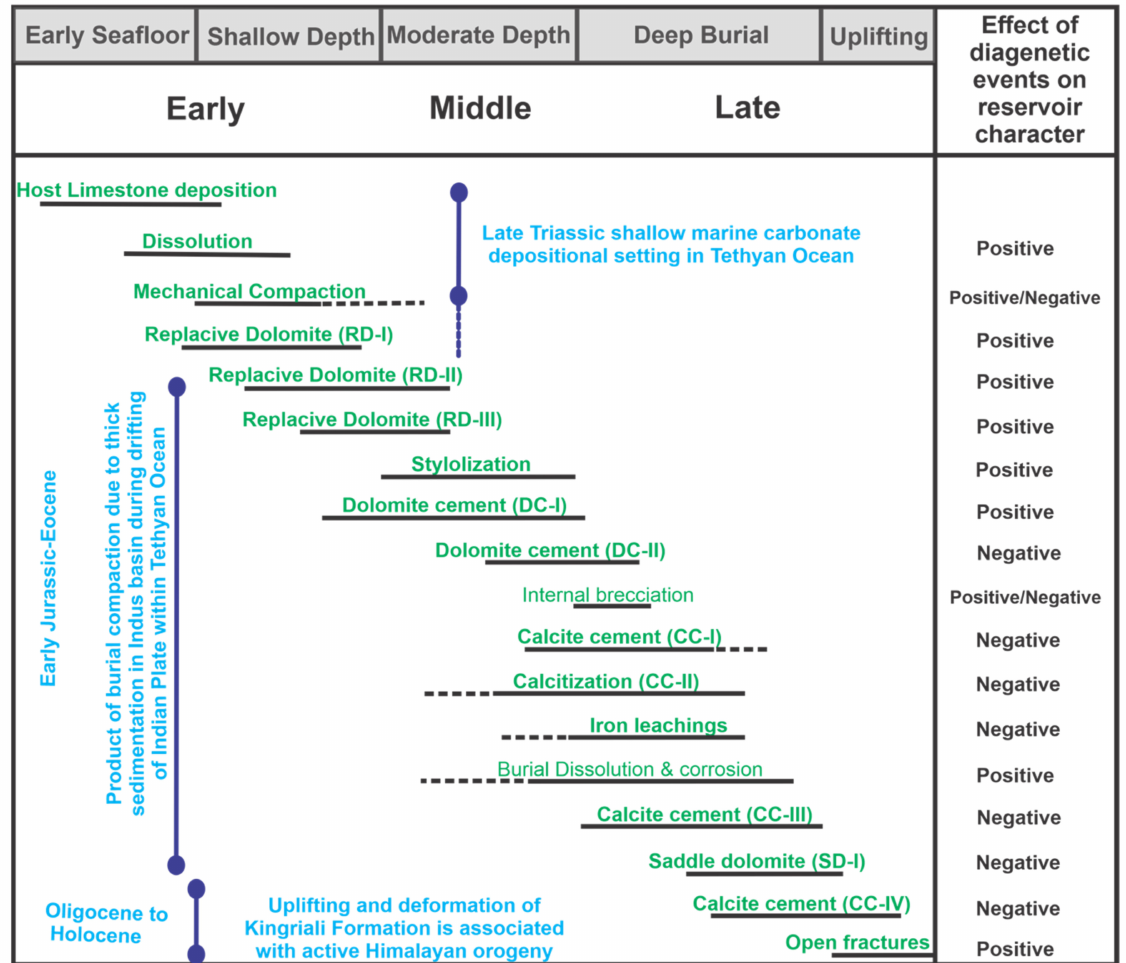
Figure 8. Proposed diagenetic para-sequences for the dolostone of the Kingriali